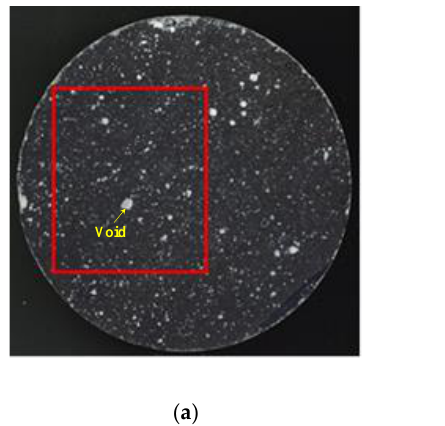
Figure 3. Evaluation of void distribution: ( a ) mortar; ( b ) matrix.